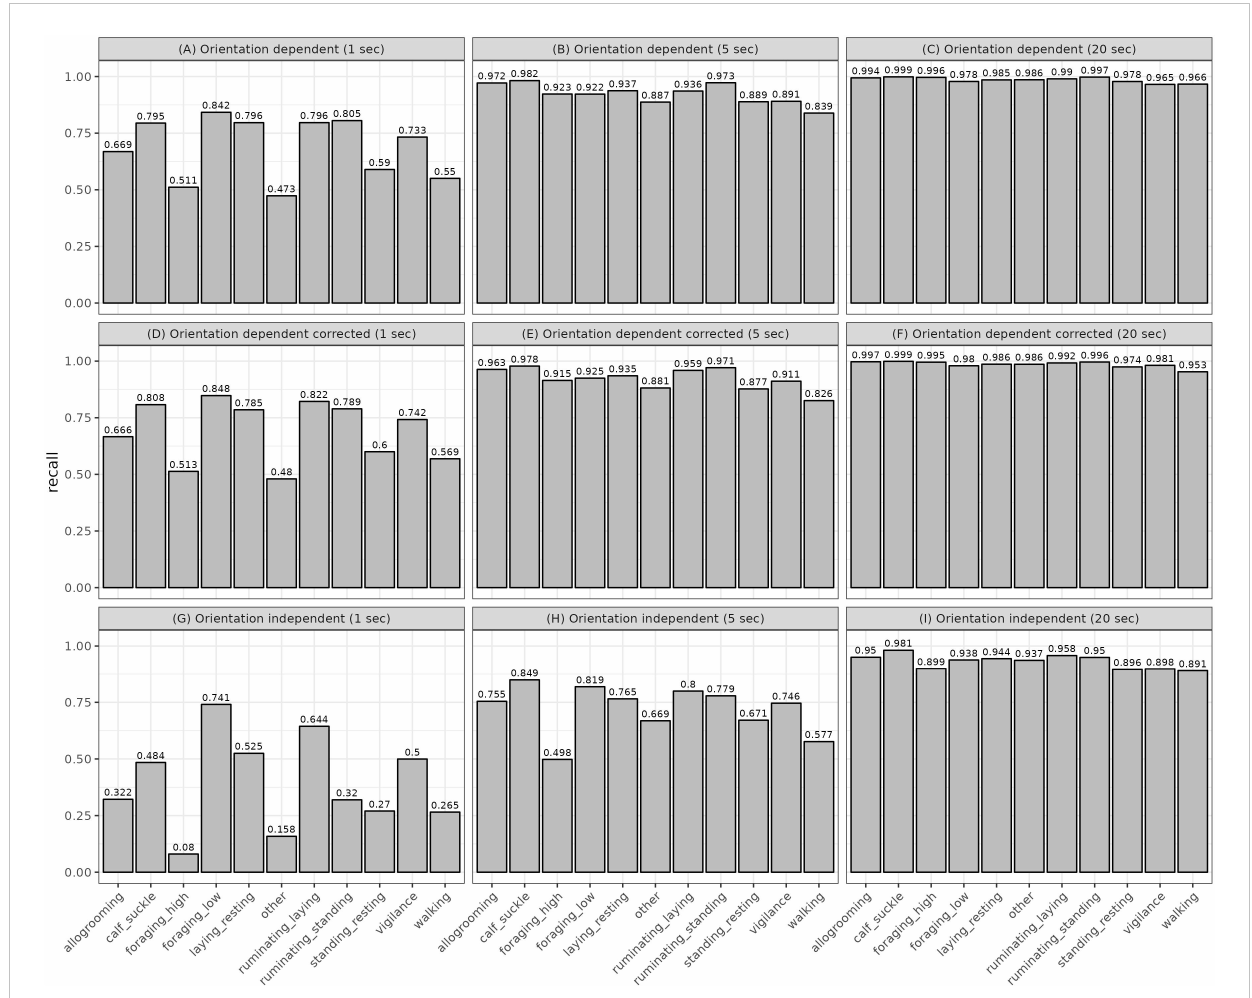
FIGURE 4 The r ecall (classi fi cation success) for each model, speci fi ed by behavior and based on the model ’ s validation data. Rows indicate orientation- dependent features, corrected orientation-dependent features, and orientation-independent features,